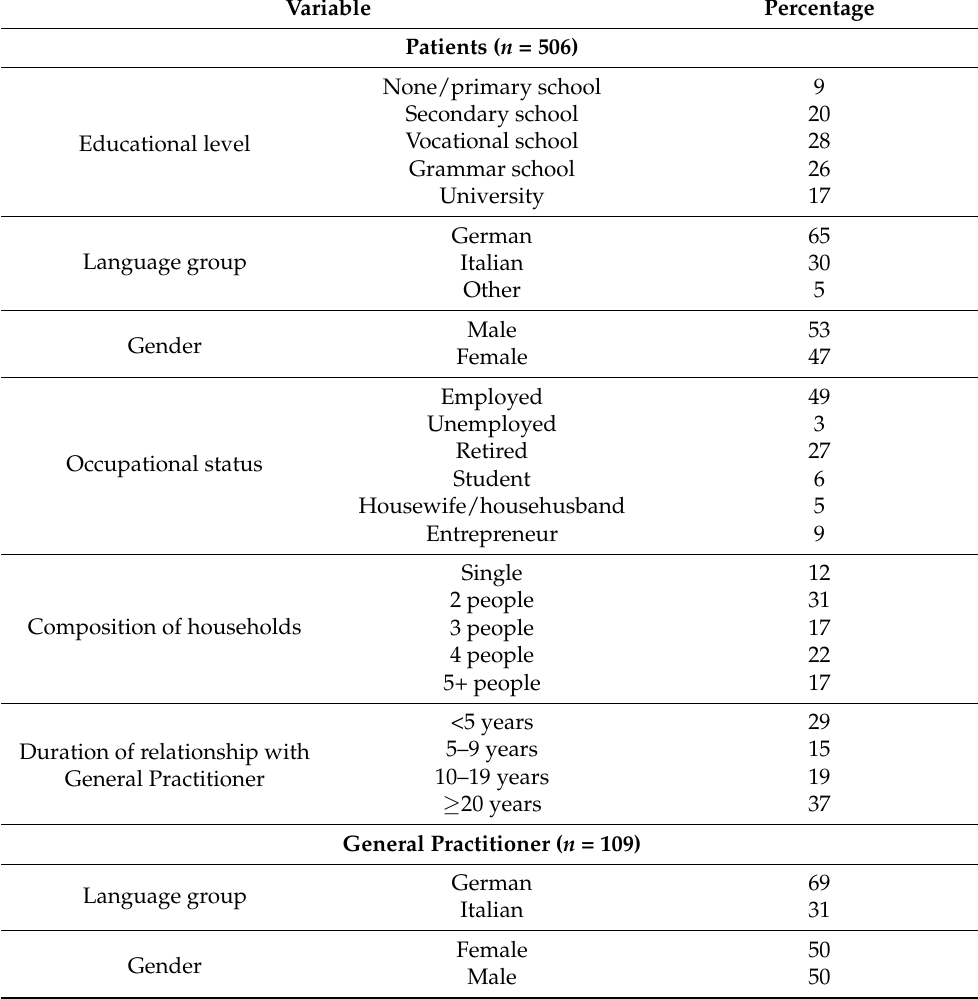
Table 1. Characteristics of the study